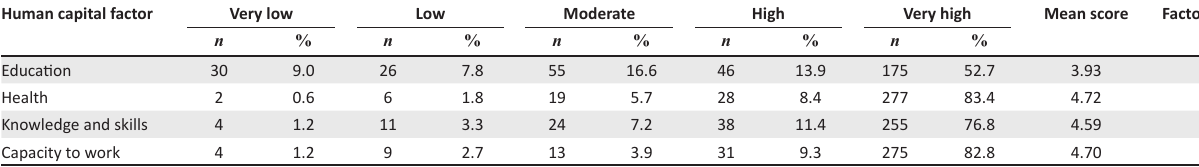
TABLE 3: Ratings of the human capital factors ( n = 332). Human capital